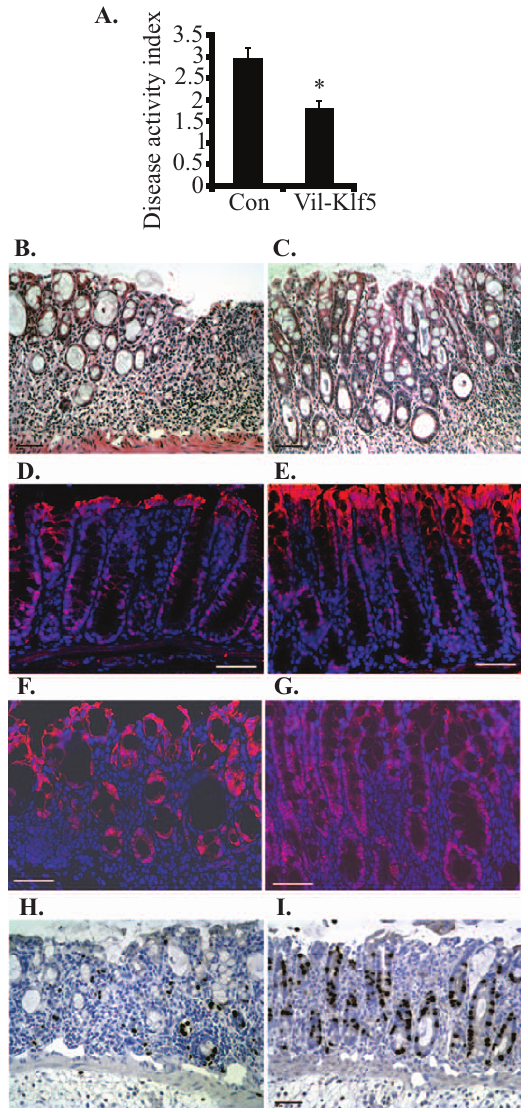
Figure 3. Villin-Klf5 mice are less susceptible to injury following DSS treatment. ( A–G ) Eight-week-old mice were treated with 3.5% DSS for 7 days. ( A ) Compared to littermate controls (Con), Villin-Klf5 mice (Vil-Klf5) had decreased sensitivity to experimental colitis with DSS, as assessed by disease activity index (*p=0.005; n=6 pairs). ( B, C ) DSS-treated control mice ( B ) had reduced intestinal epithelial repair and increased susceptibility to colitis, compared to Villin-Klf5 mice ( C ). Note the preservation of crypt architecture in Villin-Klf5 mice. ( D–G ) Immunofluorescence confirmed that, at day 0, compared to controls ( D ) , Villin-Klf5 mice ( E ) had increased KLF5 expression in colonic epithelial cells. At day 7 of DSS treatment, compared to controls ( F ) , nuclear KLF5 expression in colonic epithelia of Villin-Klf5 mice was markedly increased ( G ). ( H, I ) Compared to colonic mucosa from control mice ( H ), colonic mucosa of Villin-Klf5 mice ( I ) demonstrated increased numbers of BrdU-positive cells adjacent to the sites of ulceration. Scale bars: 50 m m. [23] but are protected from renal injuries [34]. Taken together, these observations show the importance of studying the role of KLF5 in different cell types, tissues, and context. The results presented here demonstrate that epithelial-specific expression of